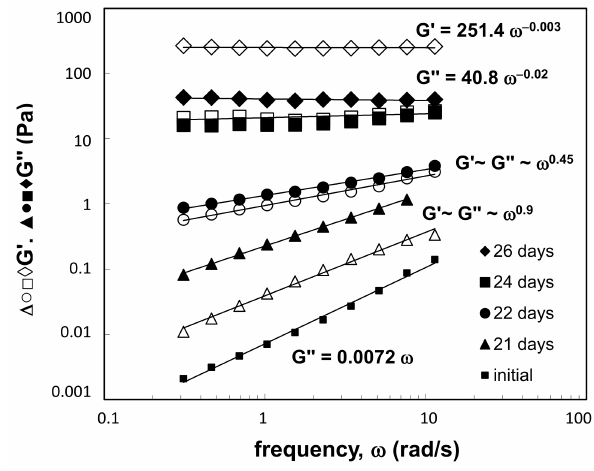
Figure 11. Dependence of dynamic moduli G (cid:48) and G (cid:48)(cid:48) on the frequency of oscillation in the range of linear viscoelastic response of the WO 3 ink. Solid symbols represent viscous modulus G (cid:48)(cid:48) , hollow symbols represent elastic modulus G (cid:48) .